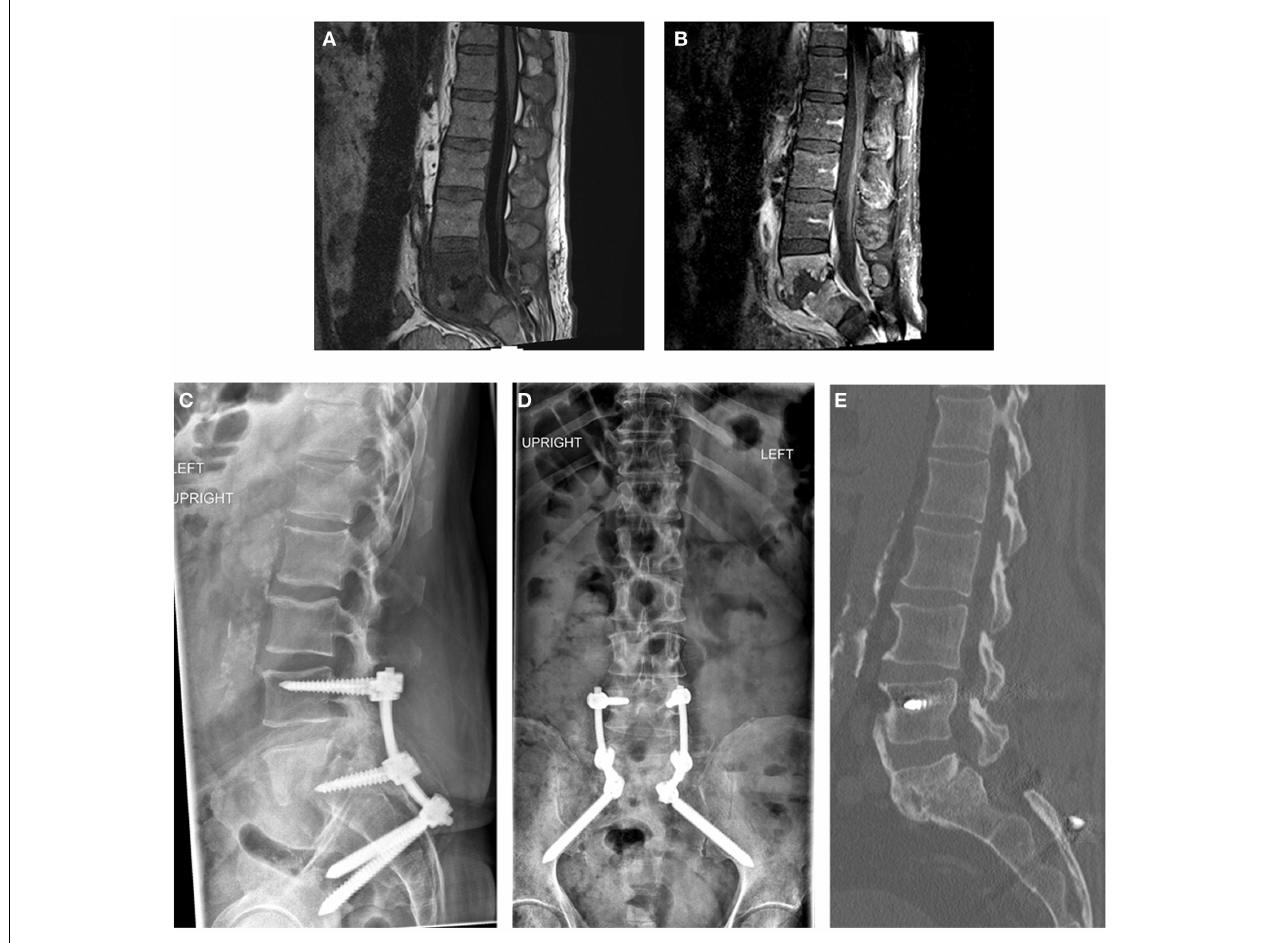
FIGURE 2 | Patient 2 . A 56-year-old man presented with mechanical low back pain. Sagittal T1-weighted magnetic resonance images of the lumbar spine with (A) and without (B) contrast demonstrated PVDO at L5–S1 with erosion of the endplates and collapse of the disk space. Epidural and prevertebral abscesses were also present. Posterior-only decompression and posterolateral fusion without formal debridement of the L5–S1 disk space was performed. Intraoperative cultures failed to yield a causative organism. Posterior instrumentation included pedicle screws at L4 and S1 with S2AI screws (C,D) ; poor bone quality precluded instrumentation of L5. Broad-spectrum antibiotics with vancomycin and ceftriaxone were administered for 6weeks, followed by oral doxycycline suppressive therapy for 2years. At 2years, CT demonstrated a solid fusion anteriorly between L5 and S1 (E) ; bridging bone is also seen between L4 and